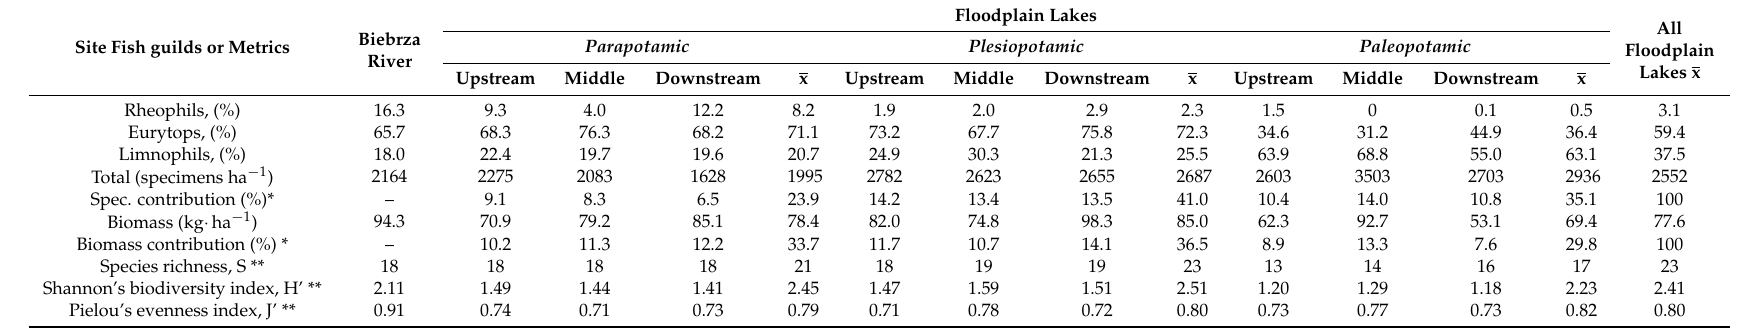
Table 4. Abundance of fish guilds in floodplain lake sites (specimens ¨ ha ´ 1 ) as well as biomass (kg ¨ ha ´ 1 ) and biodiversity metrics of ichthyofauna in the present study in the Biebrza River in the period of 2011–2013. Denotations: * total; ** biodiversity metrics calculated as totals for the river, sites, and types of lakes; x ,